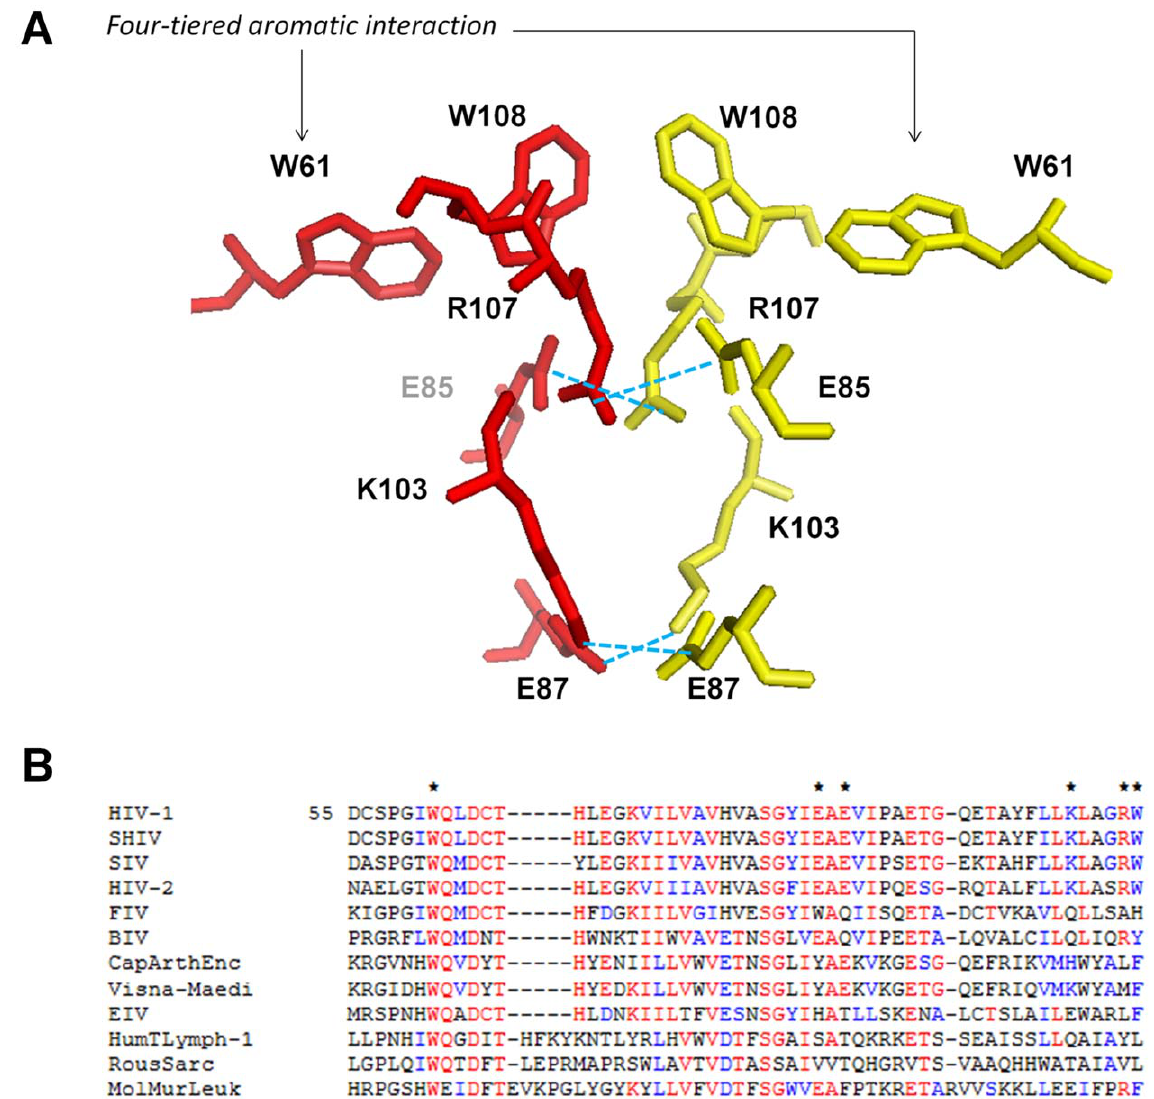
Figure 1. A symmetric region of the HIV-1 dimerization interface is conserved across other lentiviruses. (A) PyMOL representation of the highly symmetric region at the HIV-1 IN dimeric interface. A four-tiered aromatic interaction between W61 and W108 from each IN monomer is flanked by two salt bridges composed of E85 and R107, and E87 and K103 from each monomer. The four-tiered aromatic interaction donates at least 2 10 kcal/mol of stabilization energy to the interface. (B) Sequence alignment of relevant lentiviral IN residues, beginning at IN residue 55. Red text denotes highly conserved residues, while blue signifies moderately conserved. W61, E85, E87, K103, R107, and W108 are all completely conserved throughout HIV-1, SHIV, SIV, and HIV-1 viruses. Aromaticity is heavily conserved across most lentiviruses for positions 61 and